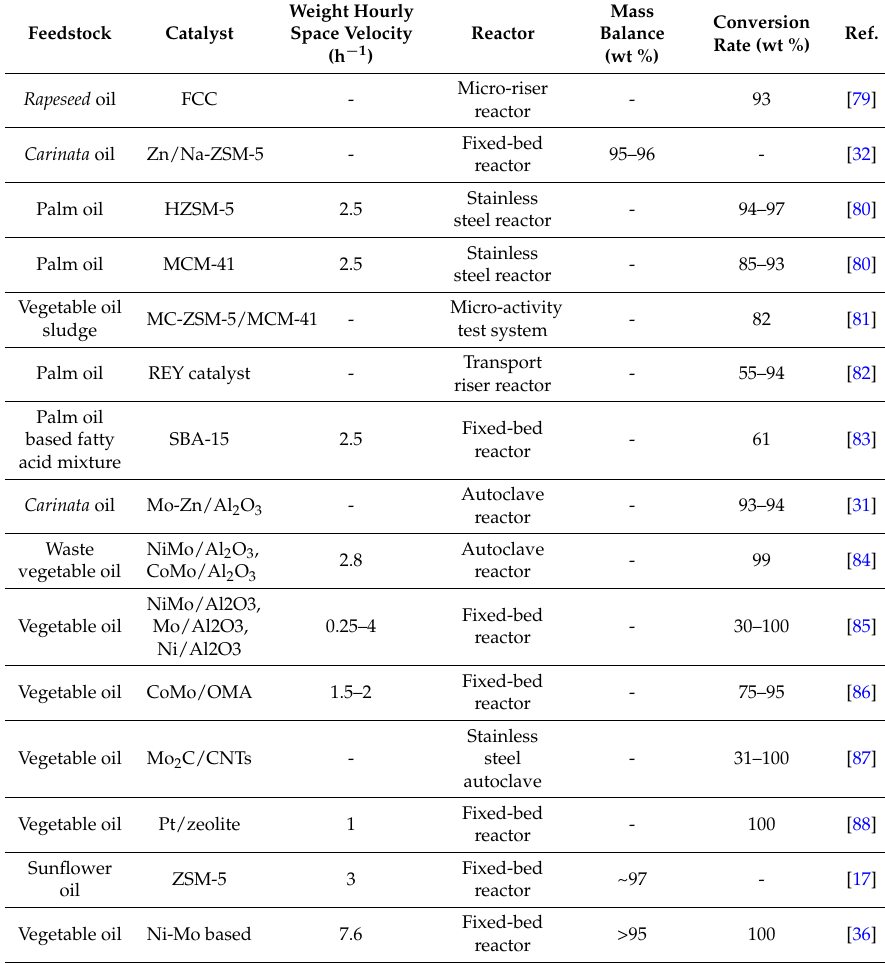
Table 5. The conversion efficiency and mass balance of vegetable oil based feedstock upgrading over different